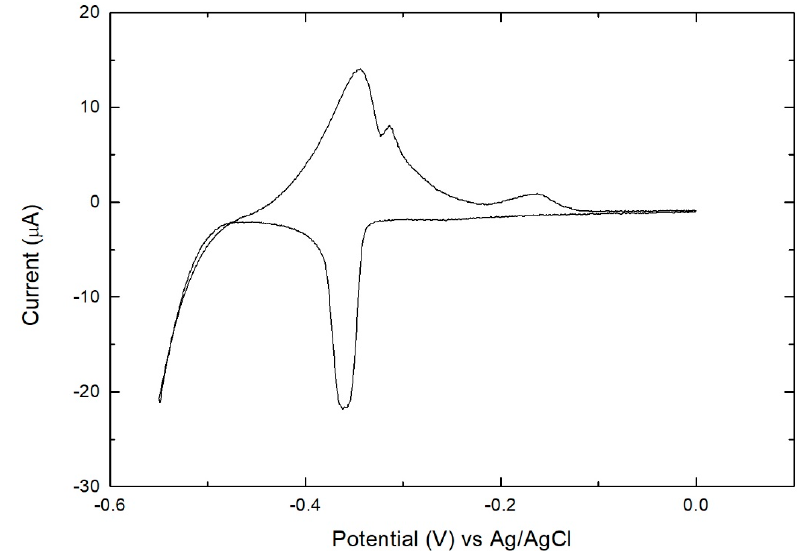
Figure 7. CV of the Bi solution at Ag (111) electrode between 0.0 and − 0.55 V at 2 mV/s.